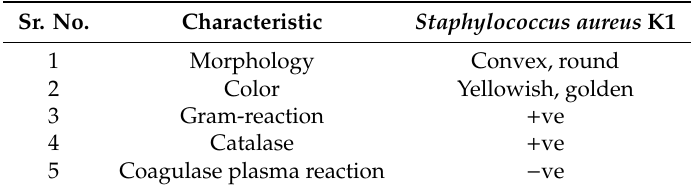
Table 2. Biochemical and morphological characteristics of S . aureus strain K1. Sr. No. Characteristic Staphylococcus aureus K1 1 Morphology Convex, round 2 Color Yellowish, golden Gram-reaction